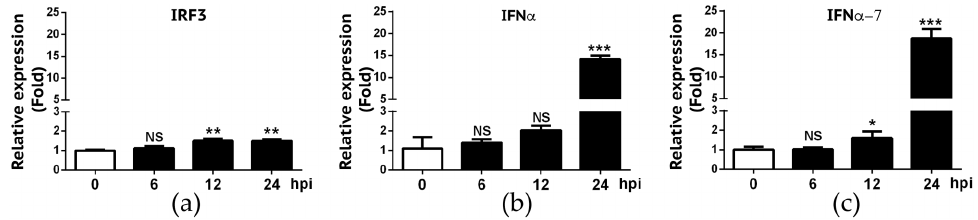
Figure 5. Validation of expression levels of IRF3, IFN- α and IFN α -7 in A549 cells infected by IBV. RNAs from IBV-infected A549 cells were analyzed for IRF3 ( a ), IFN α ( b ) and IFN α -7 ( c ) mRNA transcripts using RT-qPCR. Fold changes in transcript levels at the indicated time-point were calculated using the 2- ∆∆ Ct method so that data were normalized to both the uninfected control and the housekeeping gene GAPDH. Values represent results from three independent experiments. Statistical analysis was performed by Student’s t test. NS, no significant difference; *, P < 0.05; **, P < 0.01; ***, P < 0.001.